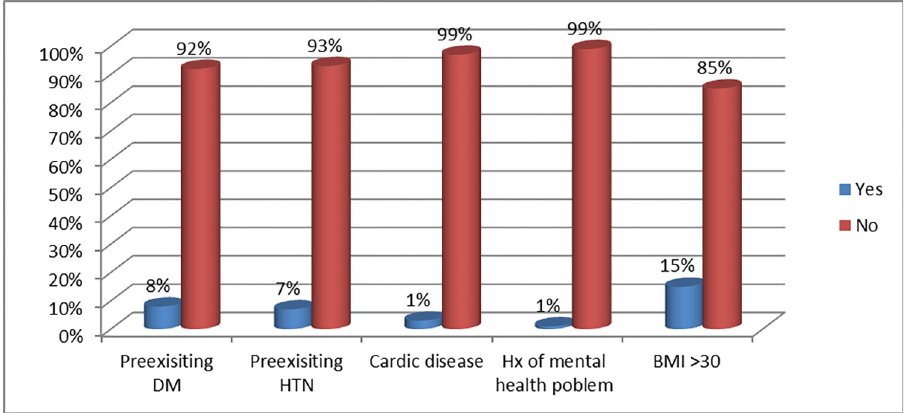
Fig 2. Previous medical history and BMI at 1st visit of the study participant (n = 980) at Hossana town public health facilities, SNNPR, Ethiopia July 2017 June